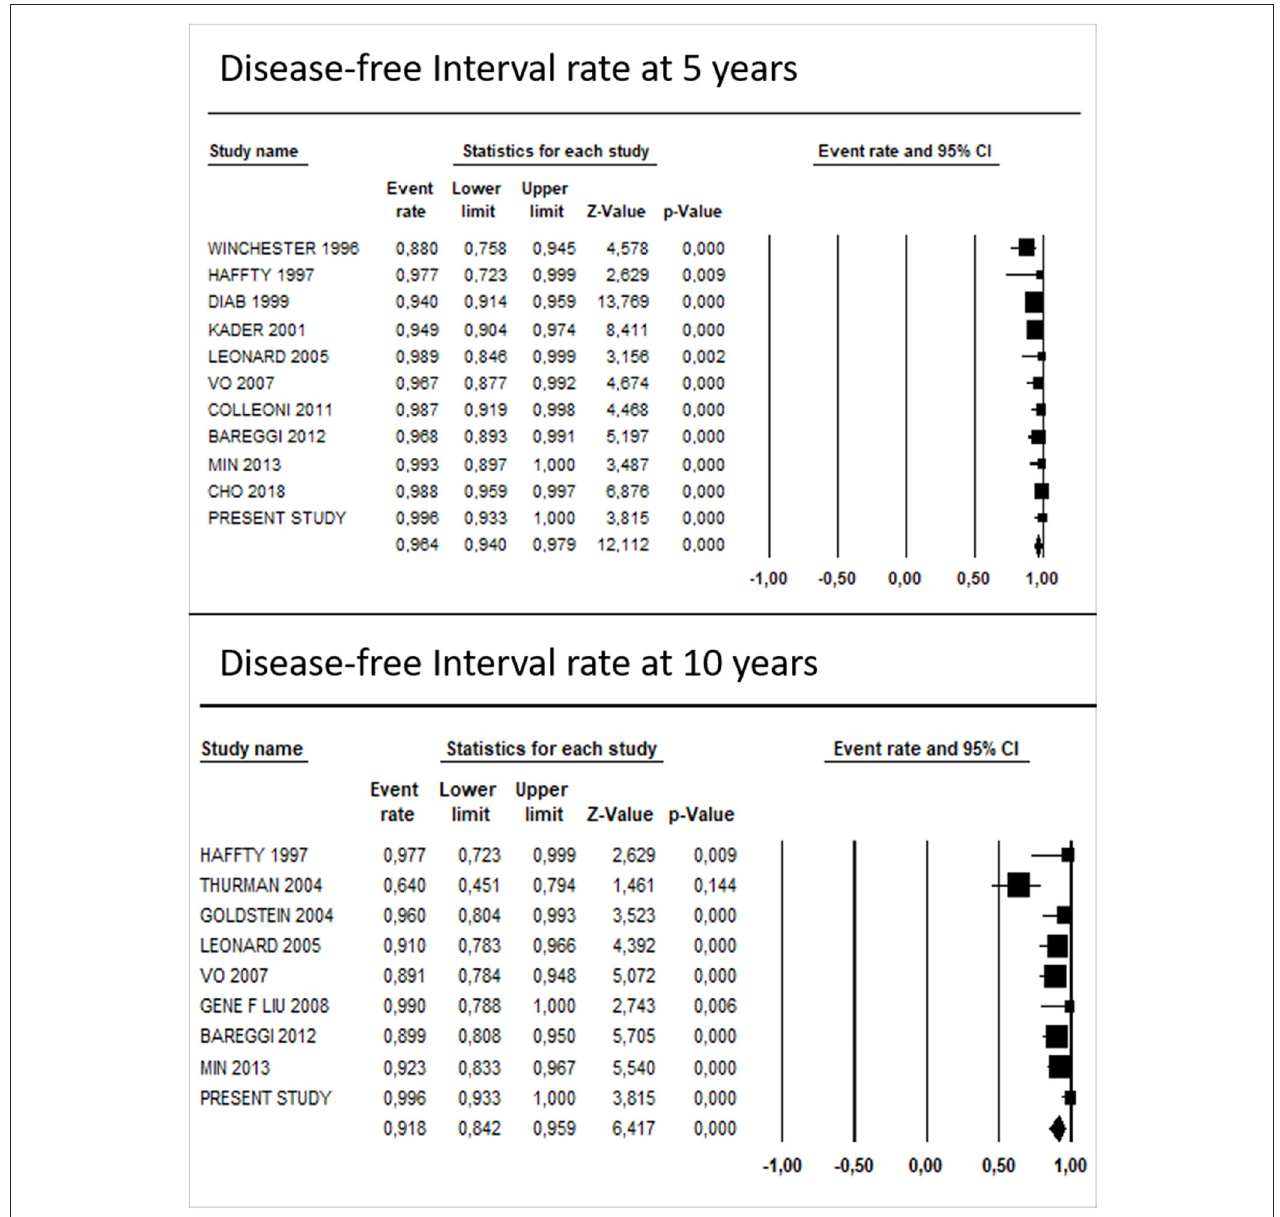
FIGURE 5 | Pooled DFI rates at 5 and 10 years of studies assessing tubular carcinomas.